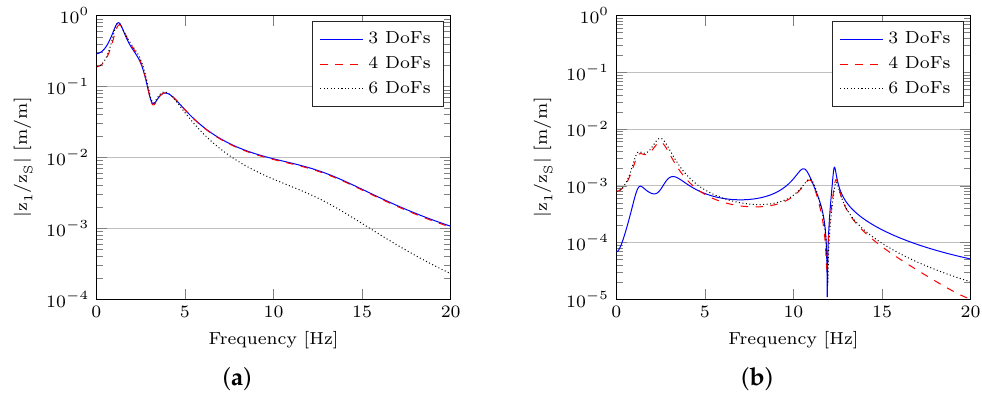
Figure 9. Transmissibility between the operating machine wheel z s and the operator’s seat on the tractor z 1 : ( a ) for a rear semi-mounted machine; ( b ) for a front semi-mounted